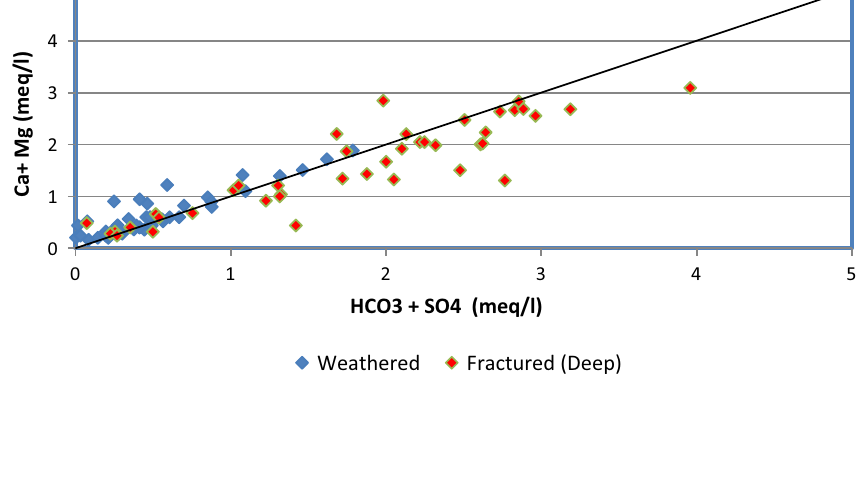
Fig. 7 Plots of Ca + Mg versus total